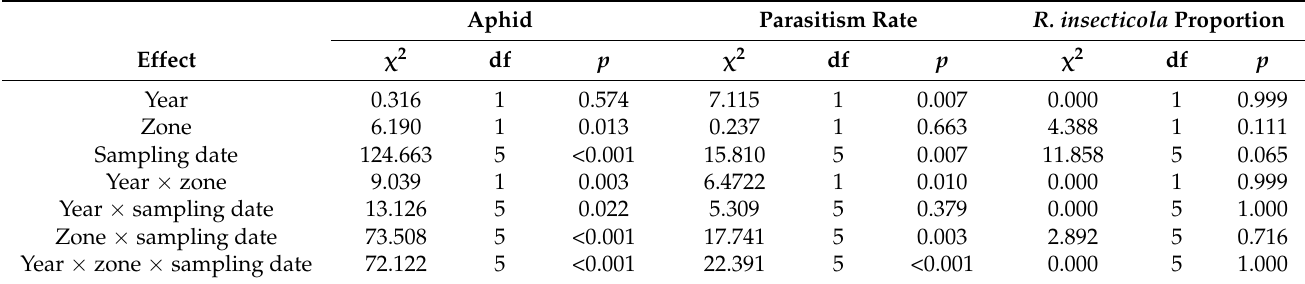
Table 1. Type II Wald chi-squared tests for Sitobion avenae density, parasitism rate, and R. insecticola